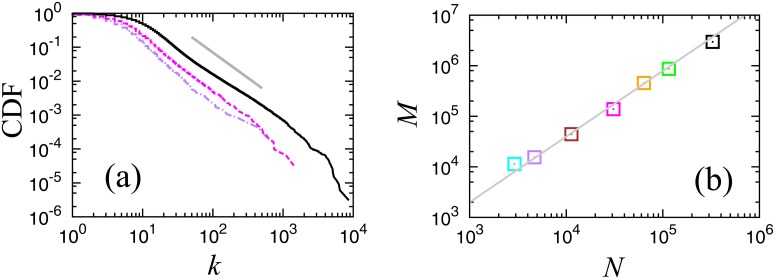

(a) Cumulative distributions of link numbers in a log-log plot. Nationwide (black solid line), Osaka prefecture (magenta dotted line), and Miyagi prefecture (purple dot-dash line). The guideline (grey thin line) shows the slope for a power law with the cumulative exponent, 1.5. (b) Initial number of links M and the number of nodes N for seven networks of different sizes in a log-log plot. The slope of the guideline shows the power exponent ϕ = 1.3. Nationwide (black), Kanto region (green), Tokyo prefecture (orange), Osaka prefecture (magenta), Fukuoka prefecture (brown), Miyagi prefecture (purple), and Kagoshima prefecture (cyan).